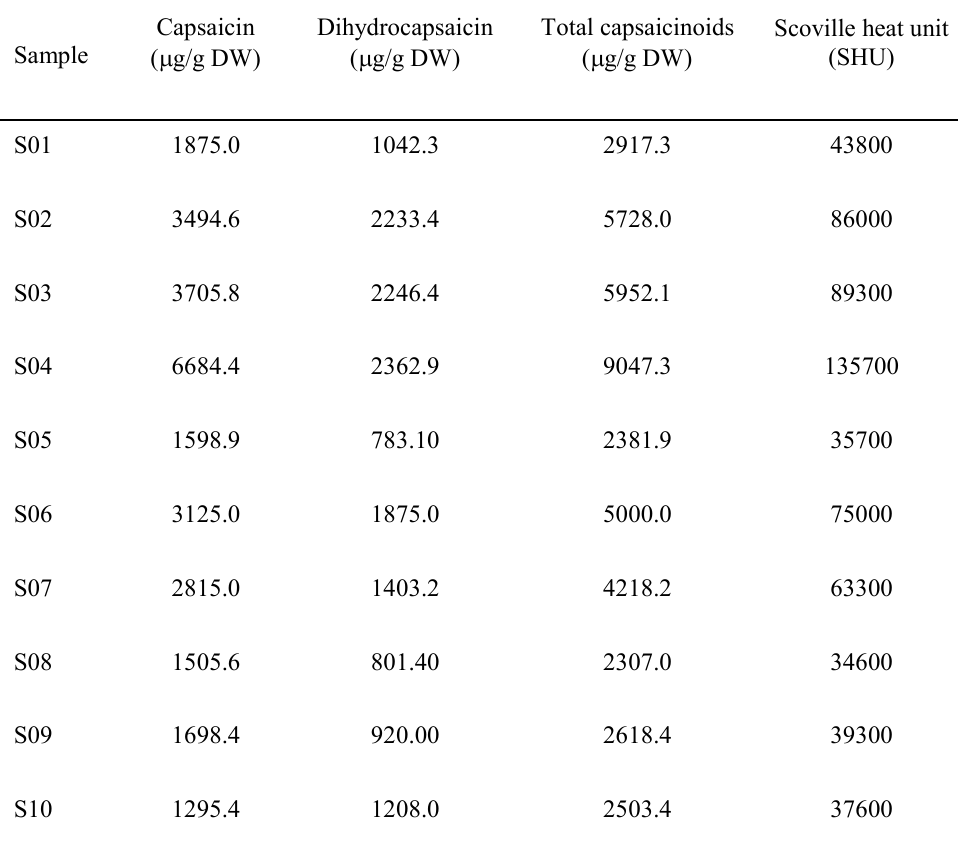
Table 3. The contents of capsaicinoids and Scoville heat unit (SHU) determined by standard